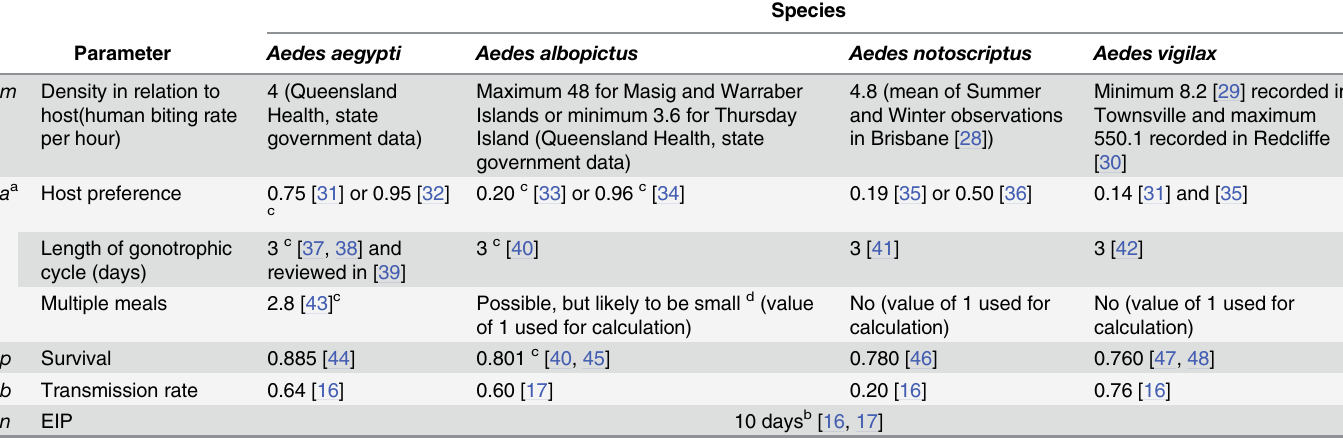
Table 1. Parameters identified from the literature and used to estimate vectorial capacity of Australian mosquito species for chikungunya virus.